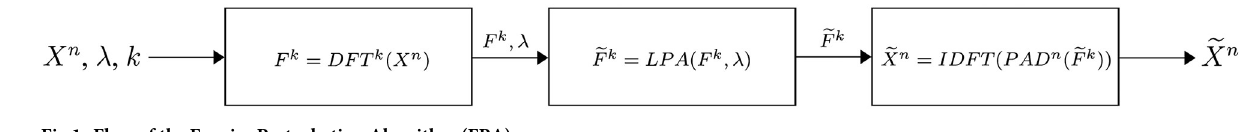
Fig 1. Flow of the Fourier Perturbation Algorithm